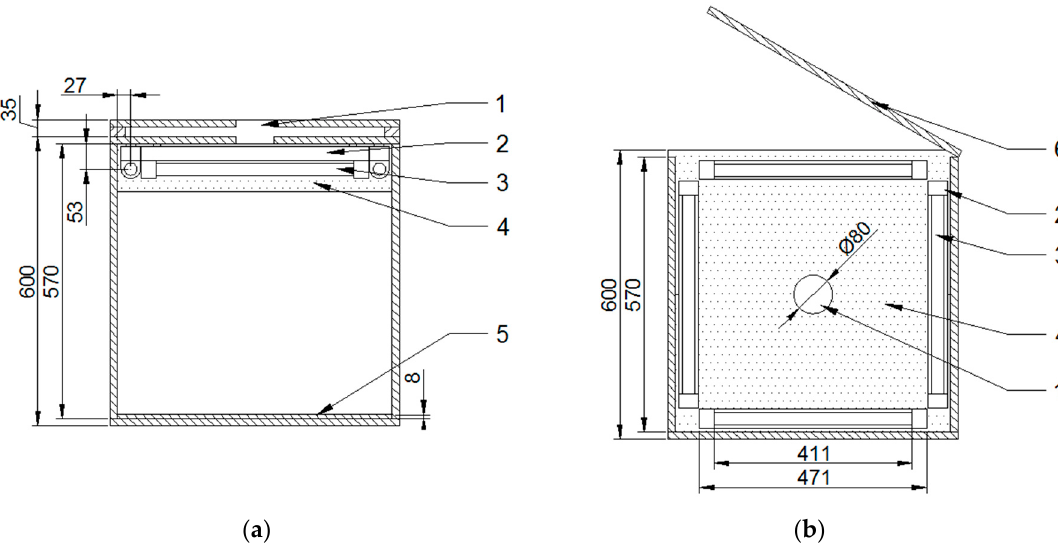
Figure 1. Diagram of the photographic chamber construction (dimensions in millimeters): ( a ) chamber interior view from the side, ( b ) view of the chamber upper inner part, 1—lens hole, 2—fluorescent lamp fixture, 3—fluorescent lamp, 4—reflector film, 5—extendable tray for material, 6—door [36].